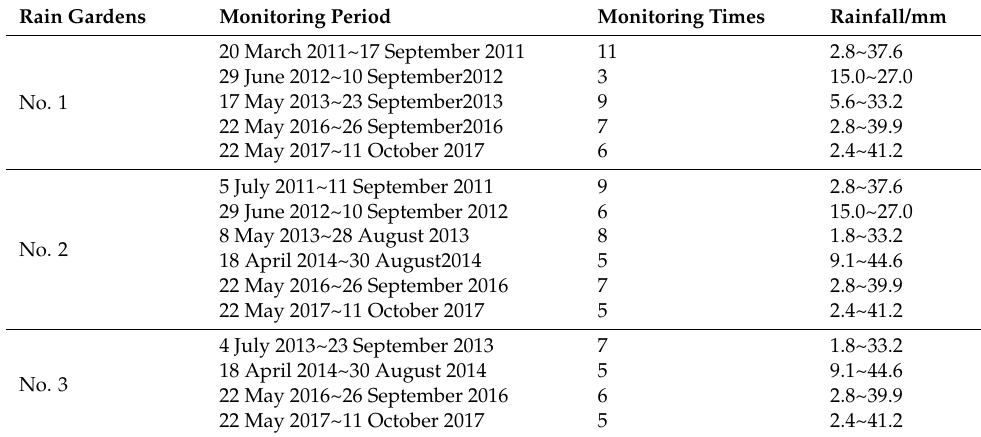
Table 2. Process of the test.